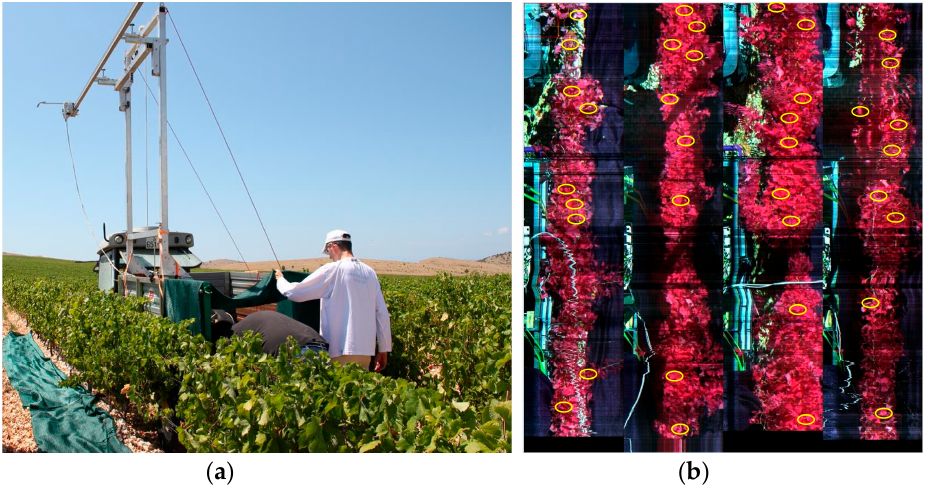
Figure 10. ( a ) Sensor bracket, HSLS V9 and control system during hyperspectral survey in Jadrtovac vineyard. ( b ) Mosaic of four hyperspectral cubes (with a combination of wavelengths: 850, 650, 550 nm) with places marked where samples were taken to calculate vegetation indices.